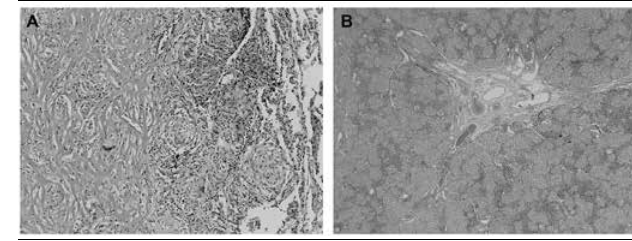
figurE 4 – Photomicrograph showing multiple noncaseating granulomas, suggestive of sarcoidosis: A) lung; B) lymph